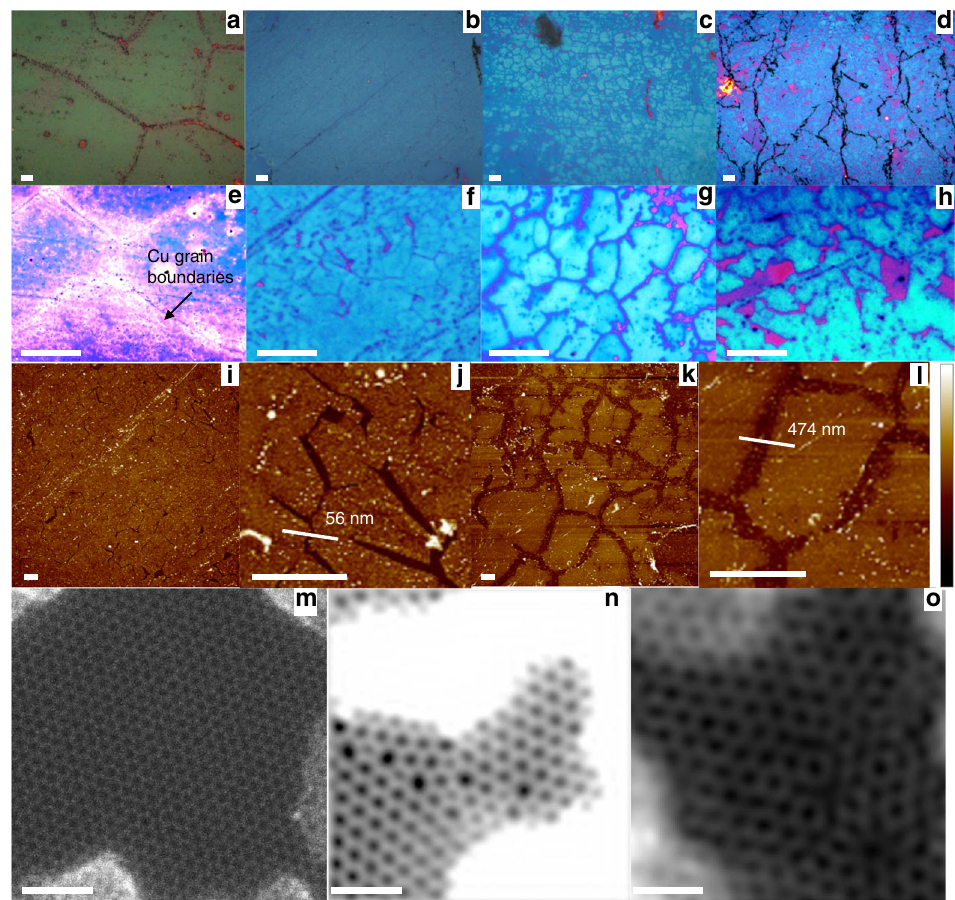
Fig. 6 Visualizing defects. Optical images of Ge underlayer etched by water percolating through defects in the graphene overlayer. a – h Show results after the water percolation experiment on samples S 1 – 4 as described in the text. a – d show the 5× images of the samples S 1 – 4 , whereas e – h show a higher magni fi cation (50 ×) of the same sequence. Although a – d show large features such as Cu GBs, graphene GBs are clearly visible in f – h . In sample S 1 , visually coalesced graphene, the predominant defects lie at the GBs of the Cu foil when it is annealed for 2 h. Grains are 50 – 100 µ m in size. In all other cases the defects lie at the coalescence boundaries, 5 – 10 µ m apart, of the graphene monolayer. GBs in S 2 annealed at higher supersaturation, are less defective than in S 3 , as indicated by the higher water percolation rates and hence more deeply etched boundaries. Even annealing in pure hydrogen, S 4 , only results in defects at the boundary and not within the grain. The purple patches in a – h correspond to graphene grains that have fl aked off. The pink dots in h correspond to triple junctions. i 40 micron square AFM scan of surface of S 2 after the percolation experiment. j 7 micron square AFM scan of surface of S 2 after permeation experiment with line scan to show etch pit width. k 40 micron square AFM scan of surface of S 3 after the percolation experiment. l 7 micron square AFM scan of surface of S 3 after percolation experiment with line scan to show etch width. m Shows a pristine graphene lattice without defects in S 1 . n Shows a representative boundary in sample S 1 with a tilt misorientation of 13.86°. o Representative boundary in sample S 4 with a misorientation of 18°. Image contrast adjusted for better visibility. Scale bars: a – h 10 μ m; i – l: 3 μ m and m – o: 1 nm. Color bar for i – l: − 20 nm to 20